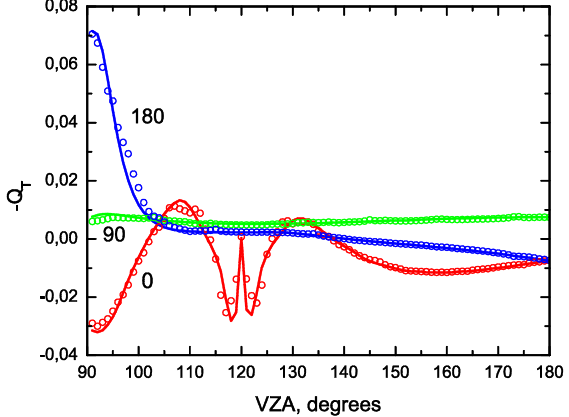
Figure 6. The normalized-Q-parameter of the Stokes vector (line—SCIATRAN, circles—Fast Line-by-Line Model (FLBLM)) in transmitted light for aerosol case and initial matrix. The number of photons is 10 5 . Relative azimuths are 0°, 90°, and 180°. Azimuths counter clock-wise.